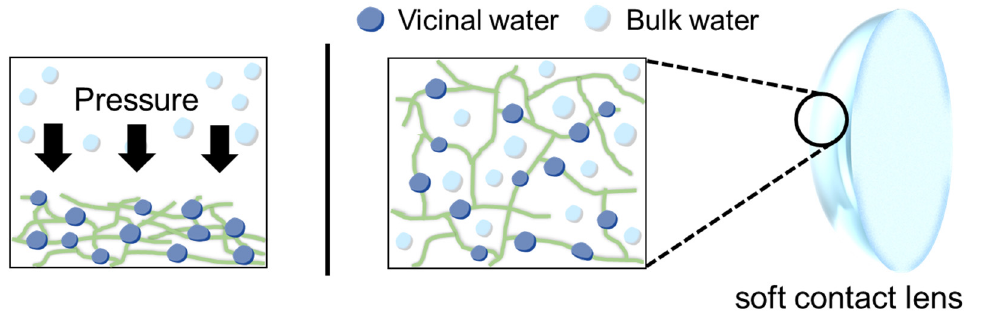
Figure 2. The dehydration process of SCLs by applying pressure.